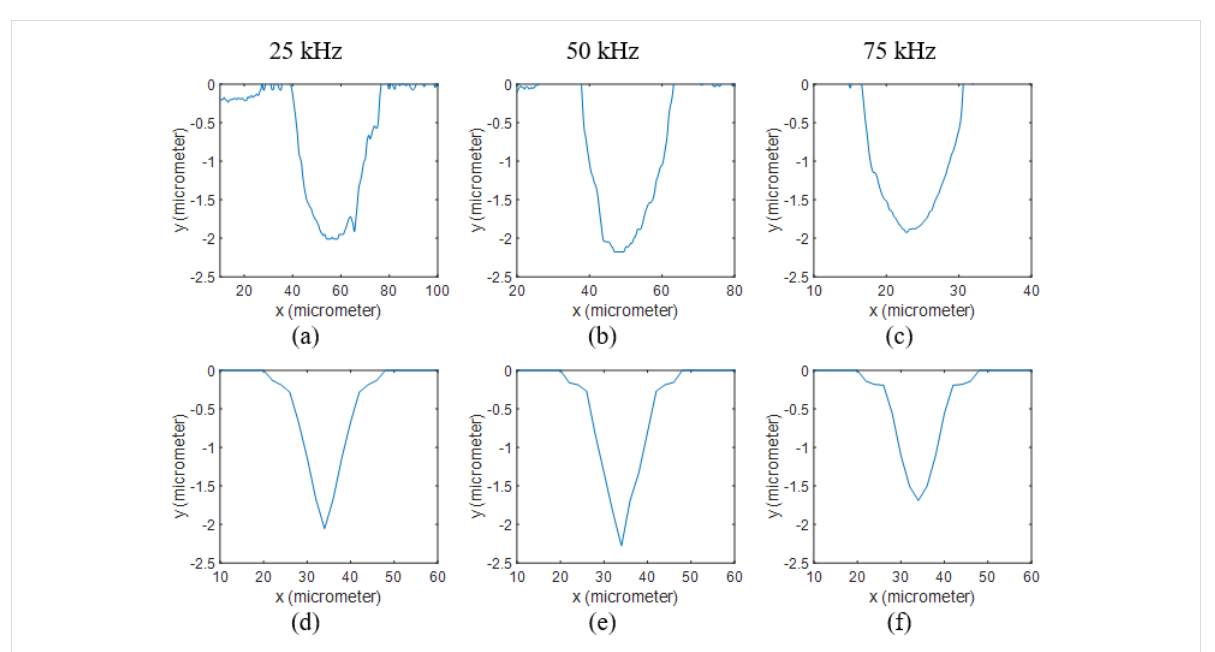
Figure 6: 2D profiles of Au coated Si samples processed at 5 W. Results obtained from measurements when using (a) 25 kHz, (b) 50 kHz and (c) 75 kHz are compared to the ones calculated through the numerical model at (d) 25 kHz, (e) 50 kHz and (f) 75 kHz.